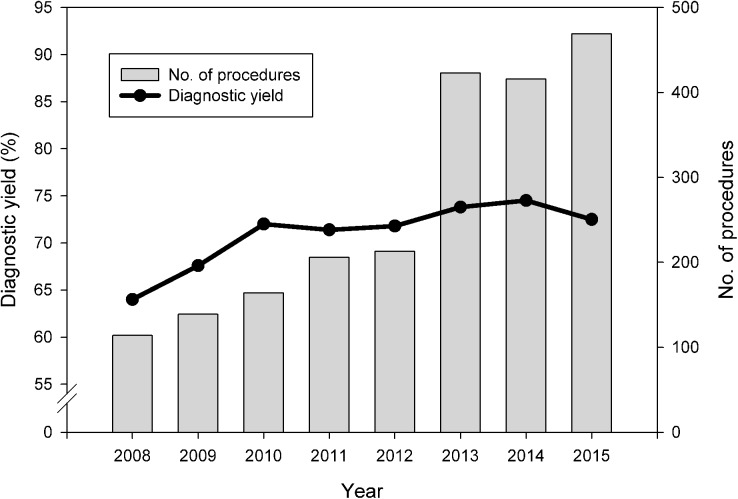
Diagnostic yield and case No. of endobronchial ultrasound-guided transbronchial biopsies over the study period.